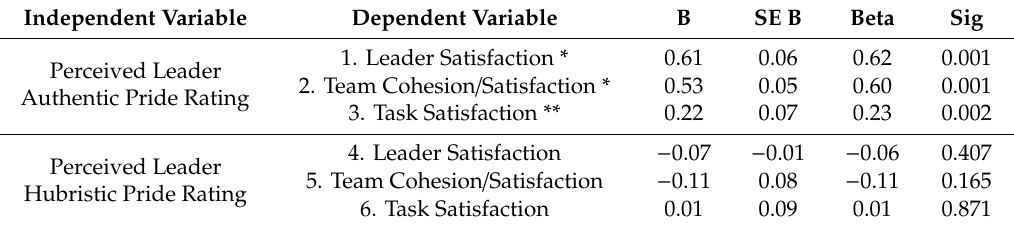
Table 2. Individual level regressions with perceived leader authentic and hubristic pride as